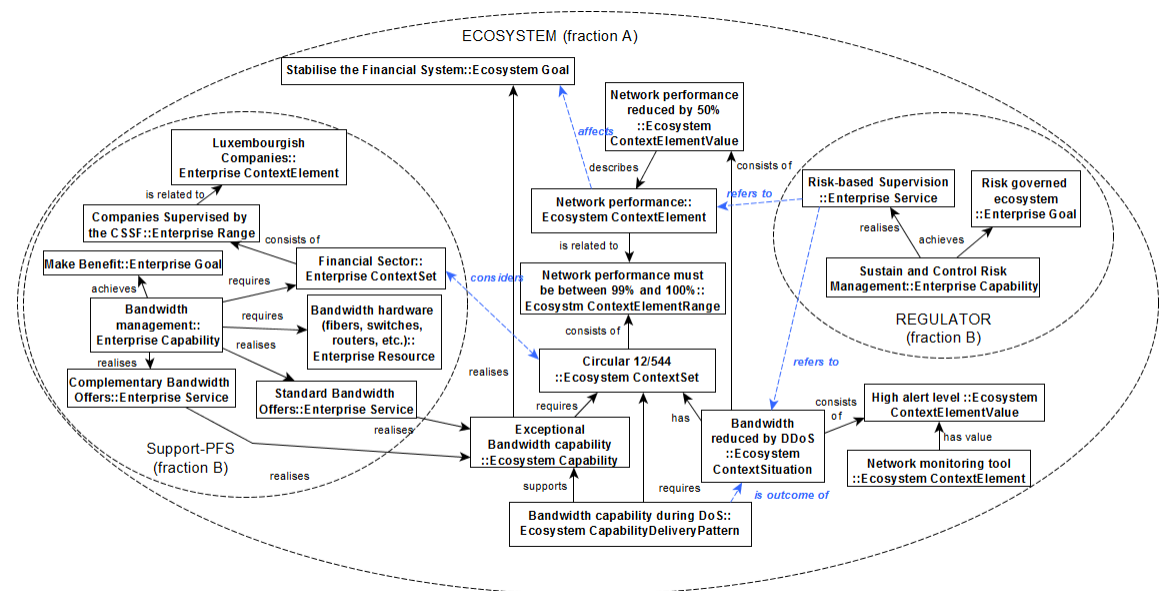
Figure 6. Business Service Ecosystem metamodel instantiated to the financial sector when a DDOS attack